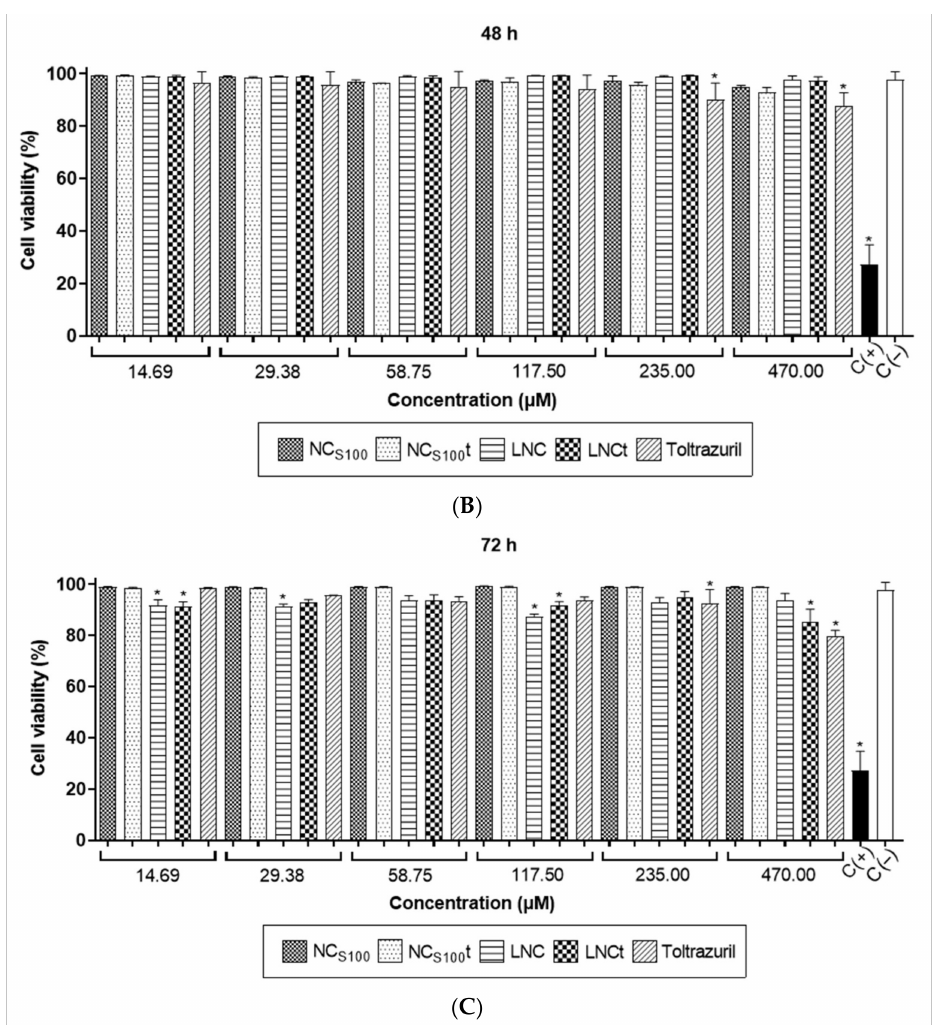
Figure 5. Cell viability of chicken fibroblasts (CEC-32 cell line) exposed to toltrazuril-loaded nanocap- sules based on DNA damage (APO-DIRECT ® kit) after ( A ) 24, ( B ) 48 and ( C ) 72 h. Data rep- resent mean ± SD ( n = 3 − 4). * p < 0.05 vs. C( − ) (one-way ANOVA, post hoc Dunnett’s test). NC S100 = blank Eudragit ® S100 nanocapsules; NC S100 t = toltrazuril-loaded Eudragit ® S100 nanocap- sules; LNC = blank lipid core nanocapsules; LNCt = toltrazuril-loaded lipid core nanocapsules; C(+) = positive control; C( − ) = negative control. Blank formulations (NC S100 and LNC) were added the same volume, respectively, to the drug-loaded